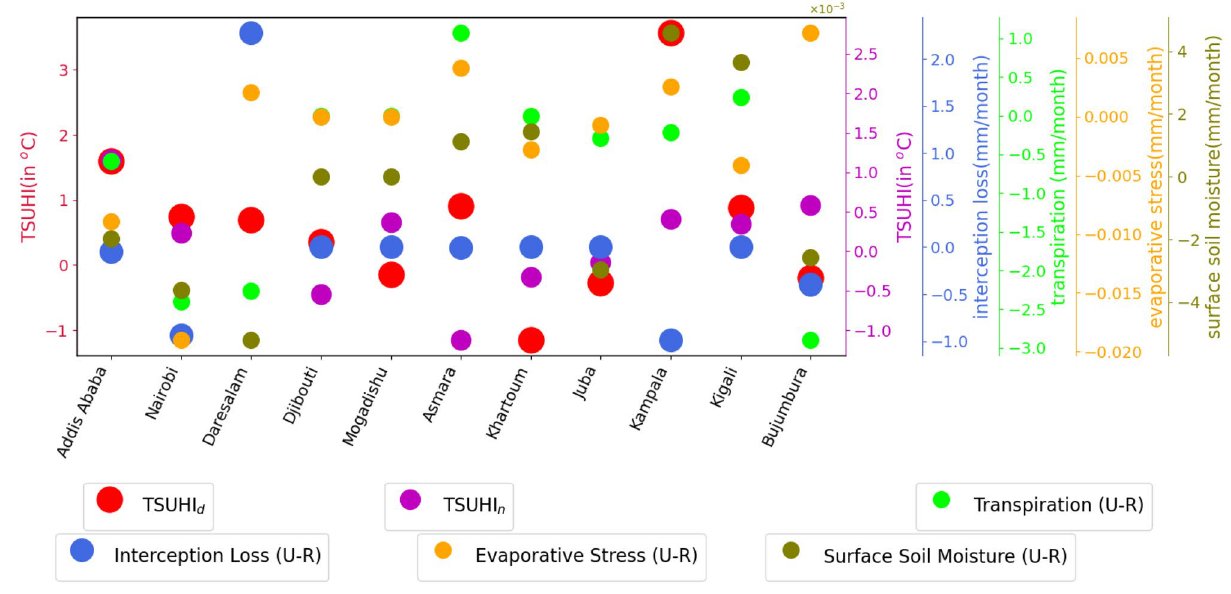
Figure 10. Urban soil moisture and transpiration affecting the tropical surface urban heat islands (TSUHIs) in the east Africa region. Different sizes and colors of circular objects are used to represent the different variables. The large circles with the red and pink colors represent tropical surface urban heat islands during the day and night respectively, the blue, light green, orange and dark green colors represent the interception loss, transpiration, evaporative stress, and surface soil moisture differences between urban and rural areas respectively. The y-axis line colors and labels have similar colors with the circles representing each of the variables. The y-axis for TSUHI n , interception loss, transpiration, evaporative stress and soil moisture are shown on the right side. The x-axis shows the corresponding capital cities in the east Africa region.